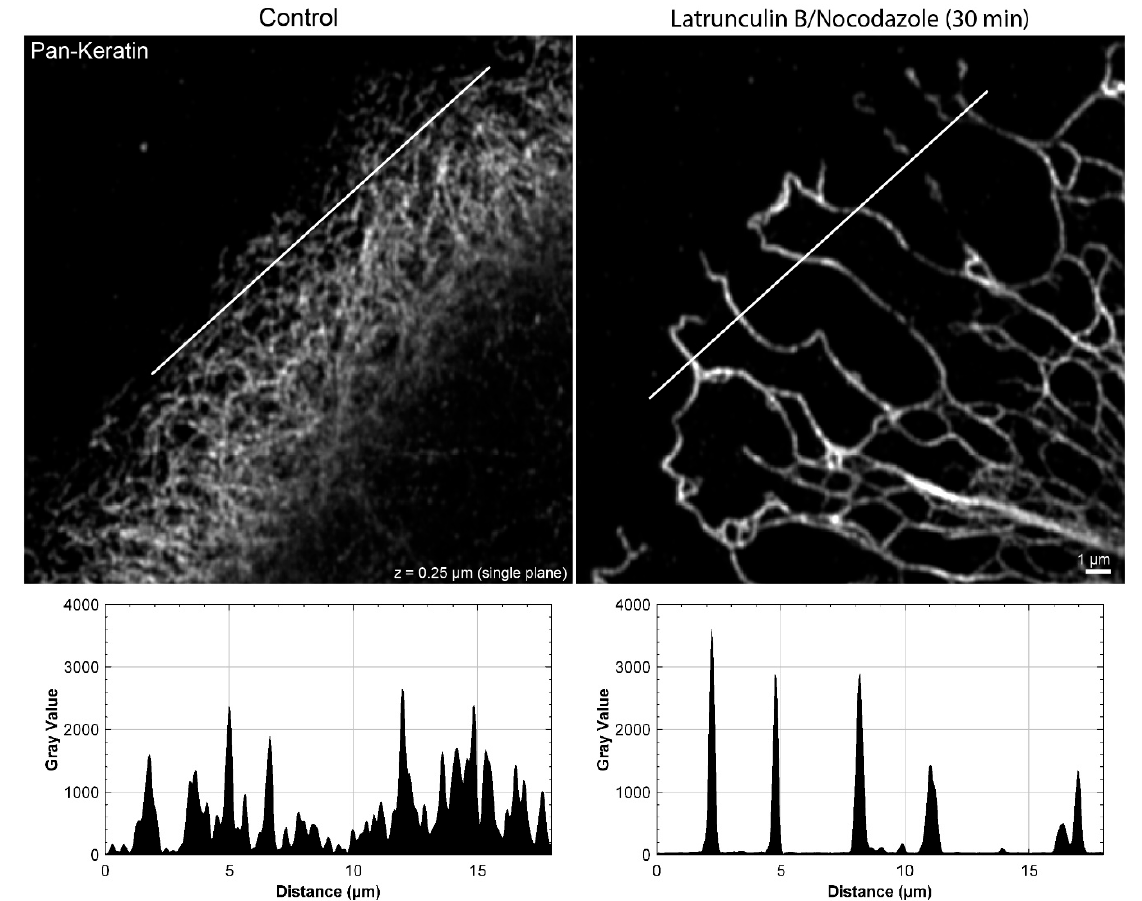
Figure A3. The peripheral keratin filament network completely re-organizes in the presence of 3 µM latrunculin B and 20 µM nocodazole. The immunofluorescence images depict keratin filaments, which are detected with pan-keratin antibodies, in single confocal planes of methanol-fixed HaCaT keratinocytes without any inhibitor (left) or after a 30 min latrunculin B/nocodazole treatment (right). The line scan shows that the fine keratin network in control cells cannot be fully resolved, whereas the bundled and strongly fluorescent keratin filaments in the network with large mesh size of the inhibitor-treated cell can be easily delineated.